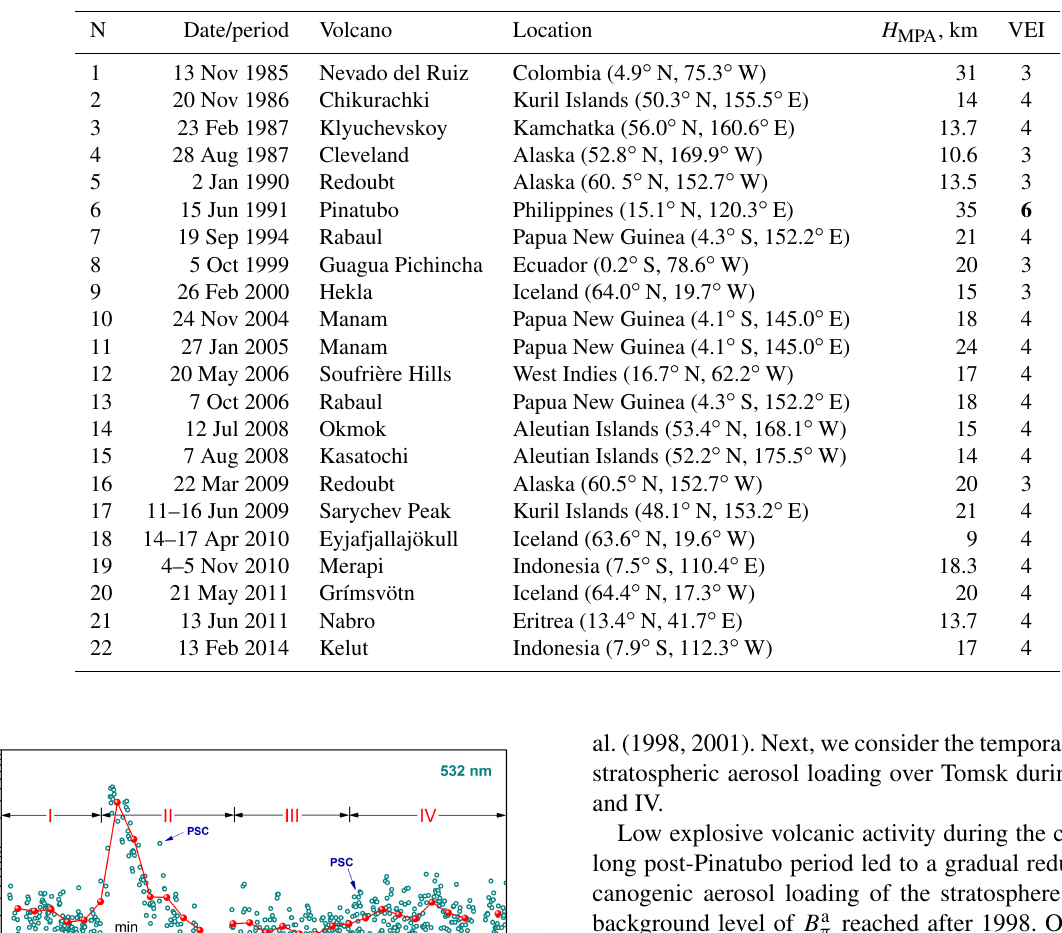
Table 1. List of volcanic eruptions that have caused the SAL volcanogenic perturbations detected over Tomsk from 1986 to the present day. The list was retrieved from the GVP data. H MPA : maximum plume altitude. The value in bold is to emphasize the most powerful volcanic eruption and its maximum VEI = 6 for the 1986–2015 period under review.